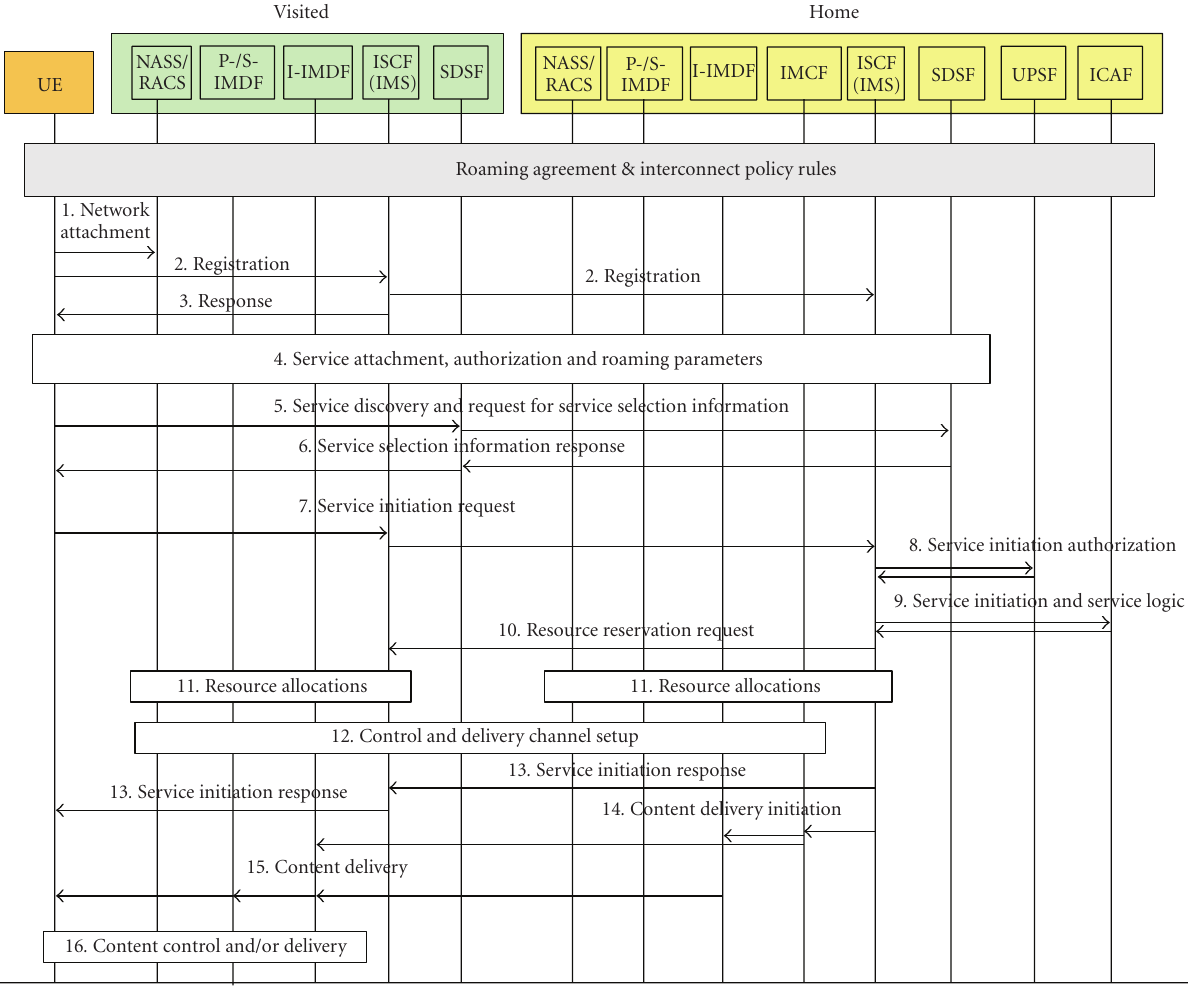
Figure 7: Procedures for interconnection with the Visited Network with CN-IPTV.